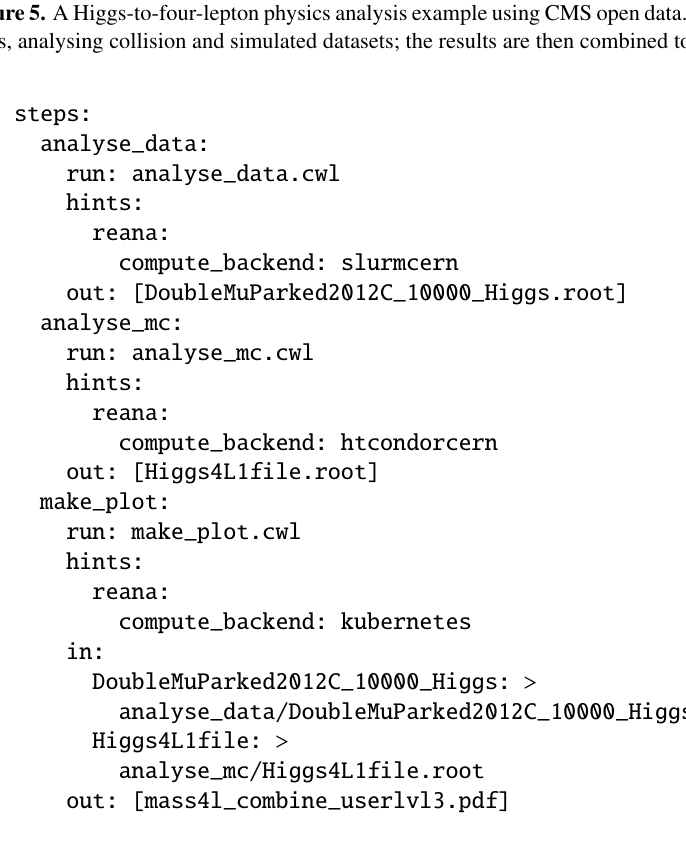
Figure 6. The workflow definition corresponding to the Higgs-to-four-lepton example analysis from Figure 5. Note the compute_backend hint provided by the user as to where each stop of the analysis is to be run. Each workflow step runs on di ff erent compute backend in this example. The REANA platform takes care of orchestrating jobs and moving inputs / outputs between platforms, as